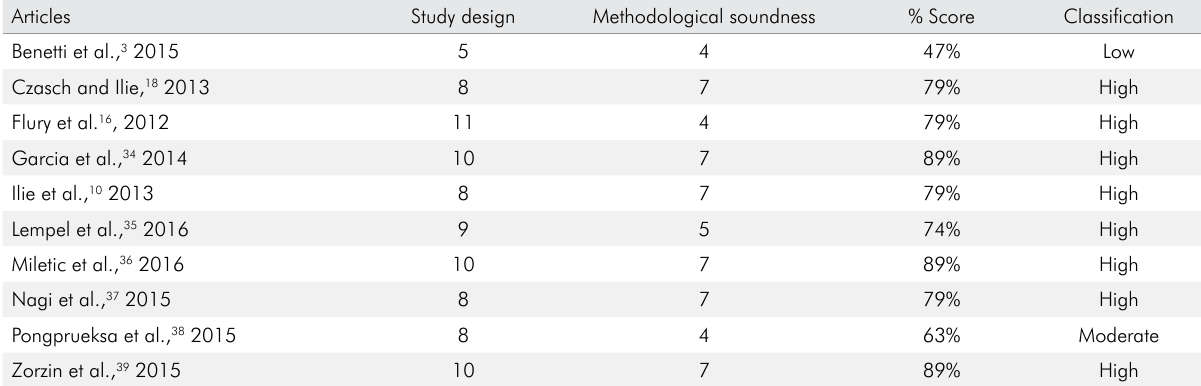
Table 6. Quality assessment scores concerning study design: classification of the evidence level (maximum score = 19